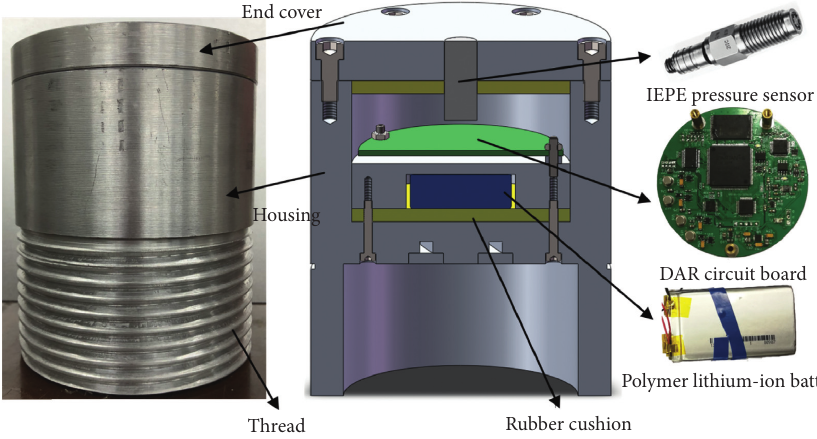
Figure 3: Structure of the